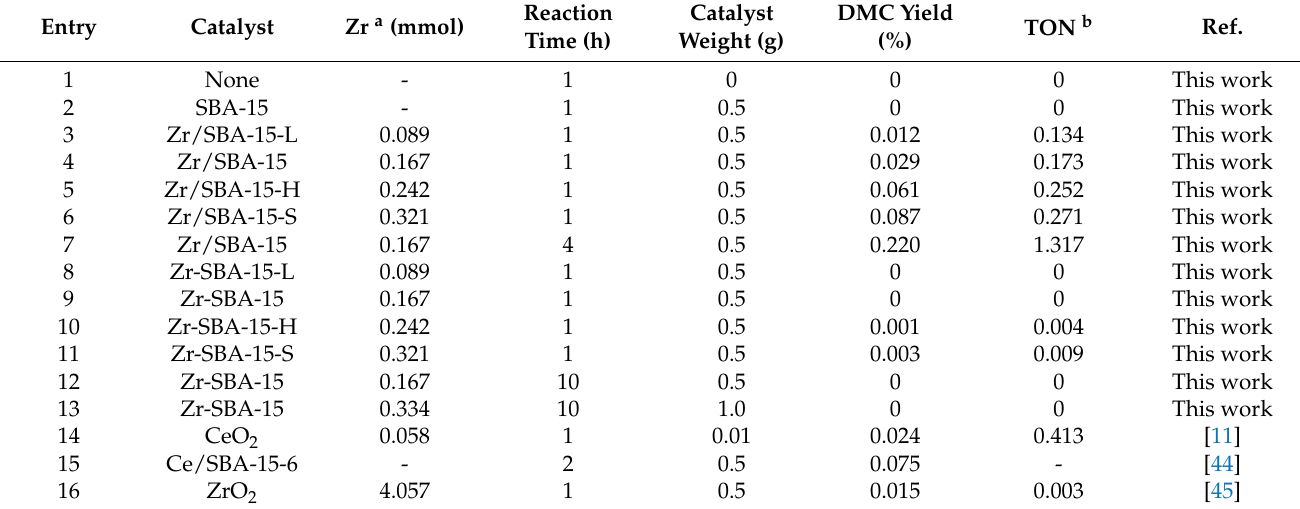
Table 1. The catalytic performance of various catalysts for the DMC synthesis from CO 2 and CH 3